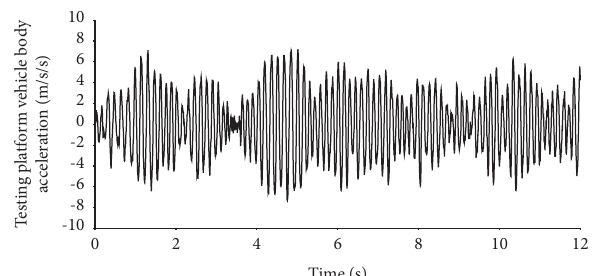
Figure 10: Time-domain plot of the vehicle body acceleration.